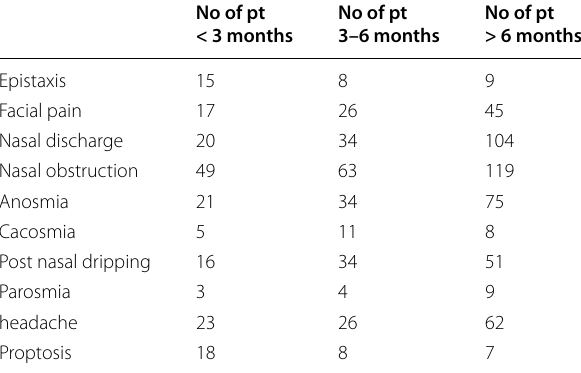
Table 1 Number of nasal symptoms with duration among patients with sinonasal masses in Khartoum ENT teaching